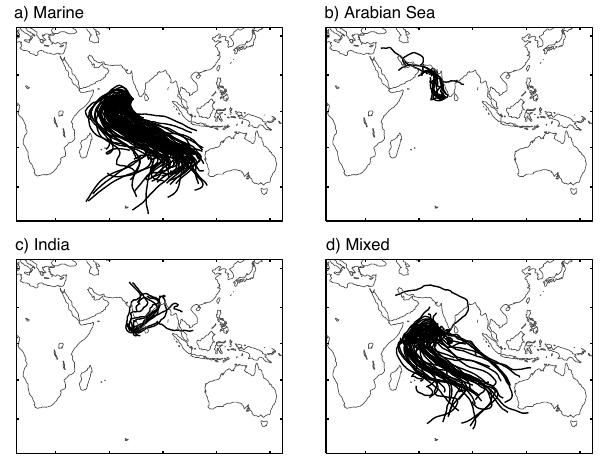
Fig. 2. Classification of trajectories arriving at MCOH, (a) Ma- rine, (b) Arabian Sea (c) Indian and (d) Mixed. For definitions see Sect.